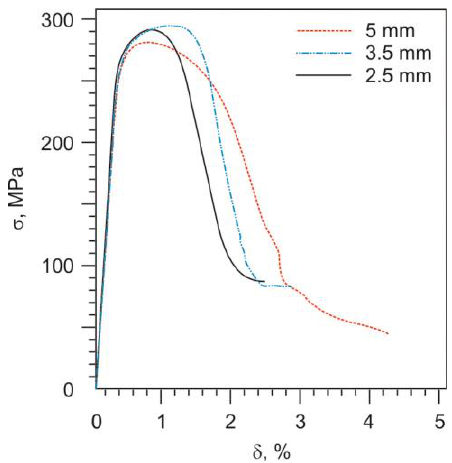
Figure 8. Stress – strain curves for composite samples with different diameters. Figure 8. Stress–strain curves for composite samples with different